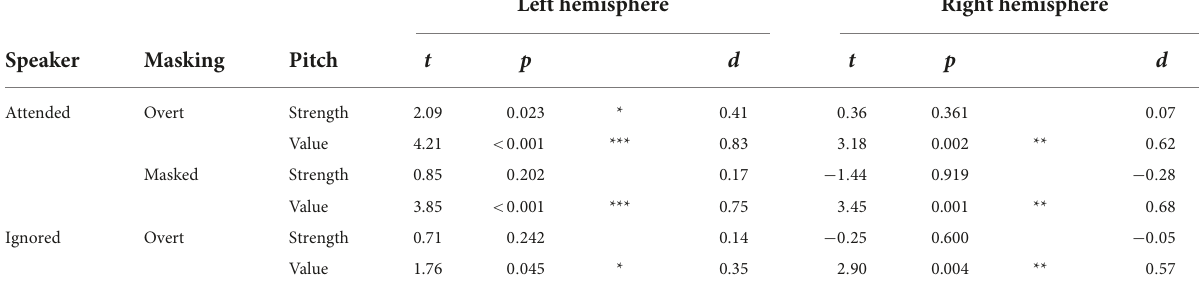
TABLE 1 In the two-talker mixture, pitch tracking is dominant due to pitch value, and not pitch strength. Left hemisphere Right